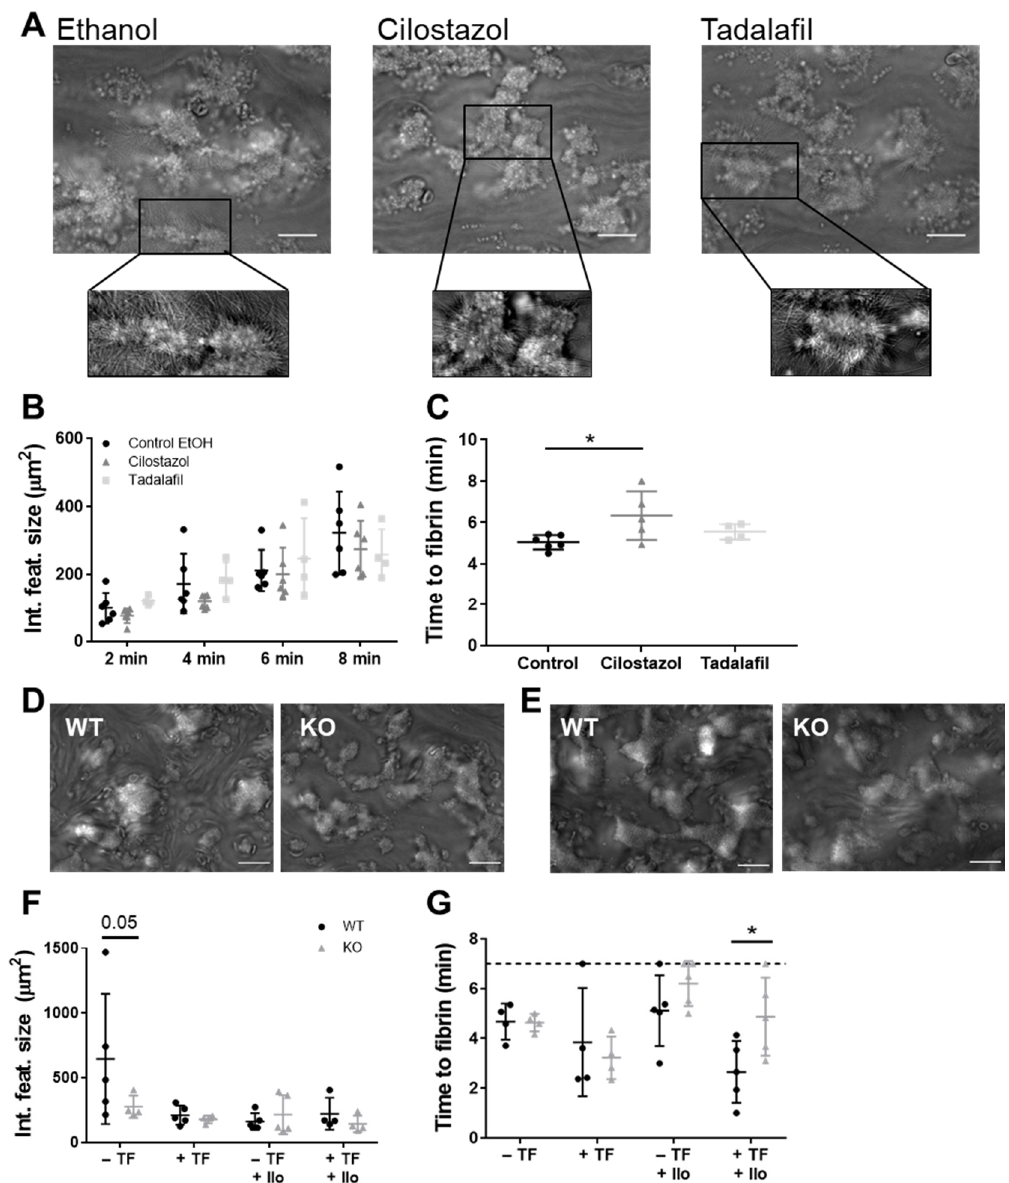
Figure 2. Effects of PDE inhibition or genetic deletion on platelet-dependent coagulation under flow over collagen. Recalcified citrate-anticoagulated human ( A – C ) or mouse ( D – G ) blood was perfused over a collagen type I surface or a combined collagen type I plus tissue factor surface for 7 (mouse) or 8 (human) min at a wall shear rate of 1000 s − 1 . ( A ) Representative brightfield images after 8 min of blood perfusion without inhibitor (0.1% ethanol) or in the presence of cilostazol (50 µ M) or tadalafil (100 nM). Quantitative analysis of integrated feature size ( µ m) ( B ) and time to fibrin formation ( C ). Representative brightfield images of blood perfusion of WT mice and Pde3a KO mice over collagen type I without ( D ) or with ( E ) tissue factor in the absence of iloprost under coagulating conditions. Quantitative analysis of integrated feature size ( F ) and time to fibrin ( G ). Scale is 20 μ m. Mean ± S.D., n = 4–6 (human) or 4–5 (mouse), * p < 0.05. Statistics: two-way ANOVA followed by Dunnett’s ( B ) or Sidak’s ( F , G ) multiple comparisons test. Time to fibrin formation (human) was tested by ordinary one-way ANOVA followed by Holm-Sidak’s multiple comparisons test ( C ). Ilo, iloprost; KO, knockout; TF, tissue factor; WT, wild